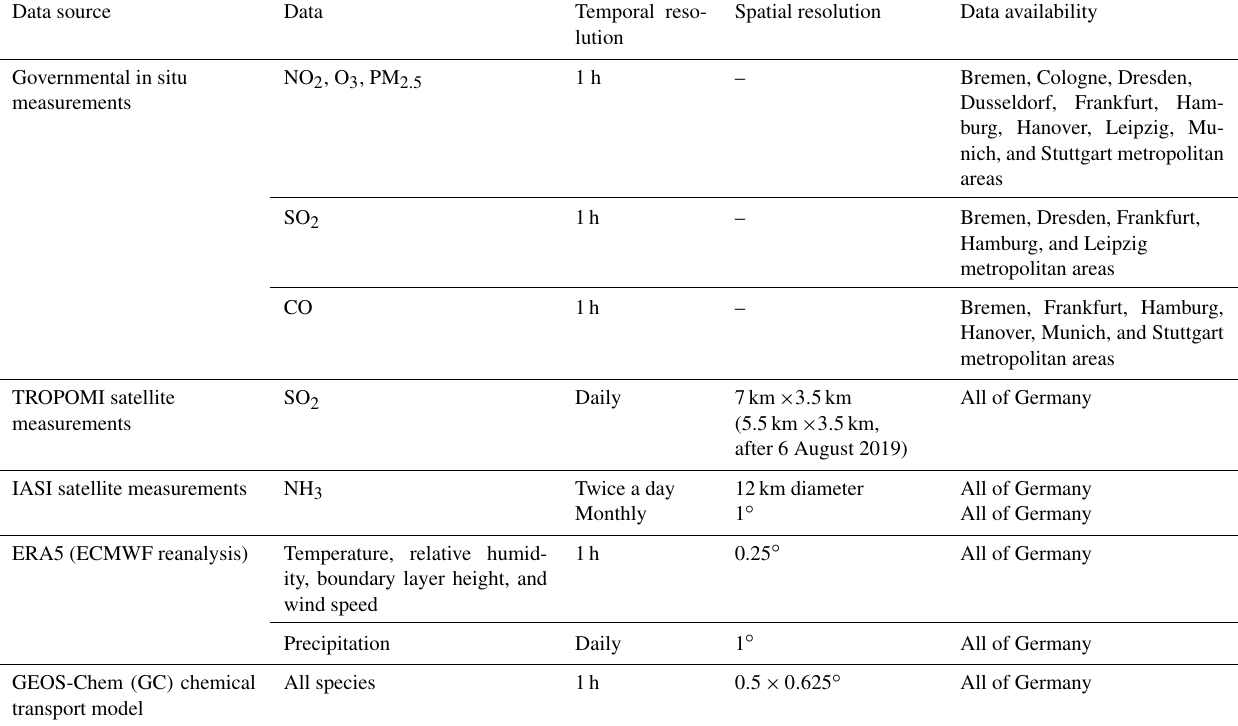
Table 1. Datasets used in this